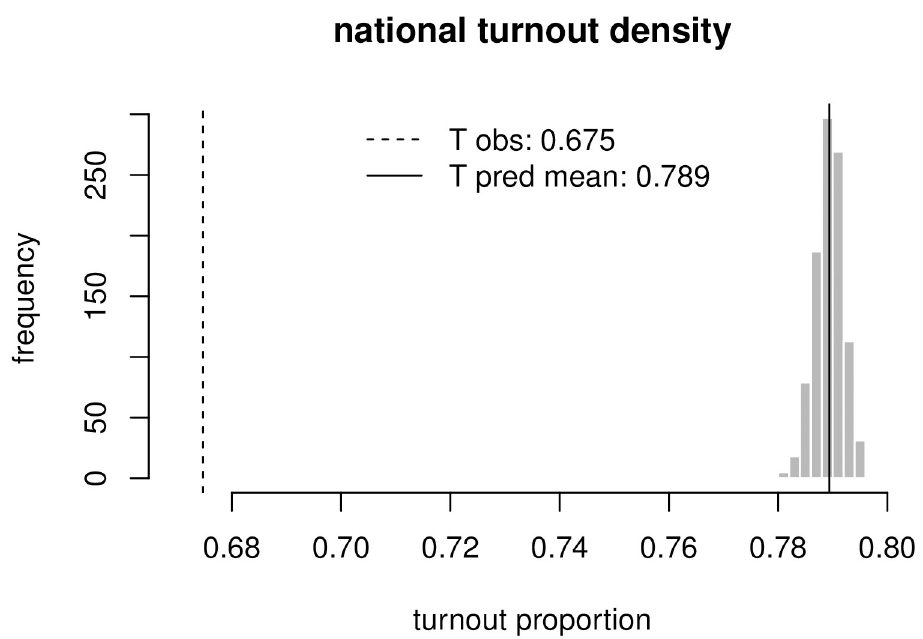
Fig 5. Seats projections at 5 weeks till the end of voting. Pr (majority) indicates the probability that a given party obtains an outright majority—272 seats or more—in the Lok